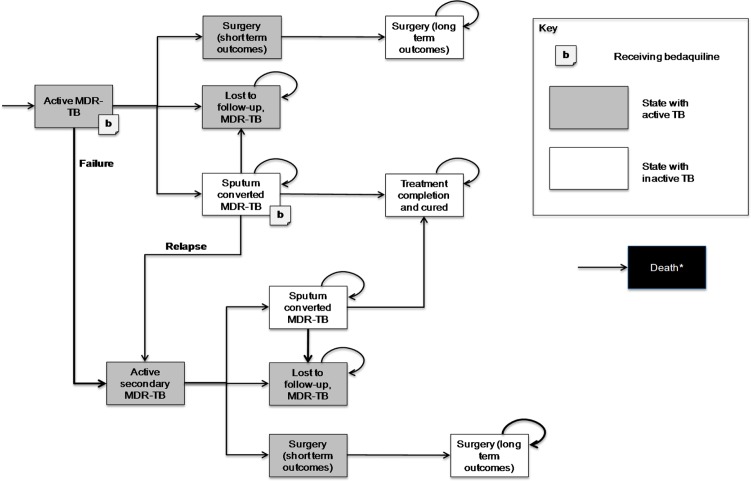
Markov model state structure.MDR-TB: multi-drug resistant tuberculosis; TB: tuberculosis. *Transitions to the death state are possible from every state, but not shown on the diagram for clarity.